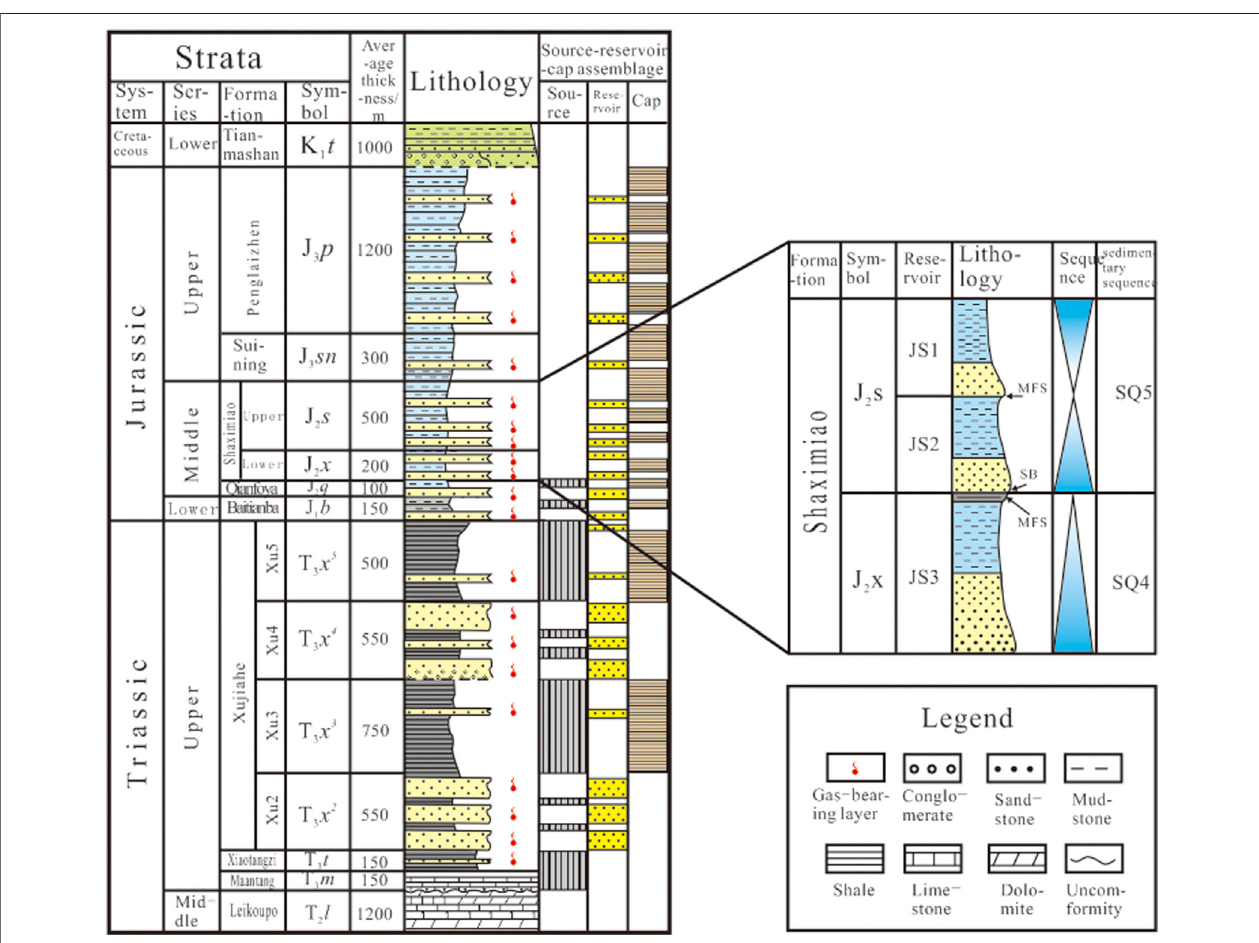
FIGURE 2 | Upper Triassic – Cretaceous stratigraphy and source – reservoir – cap rock combination in the Zhongjiang gas fi eld.